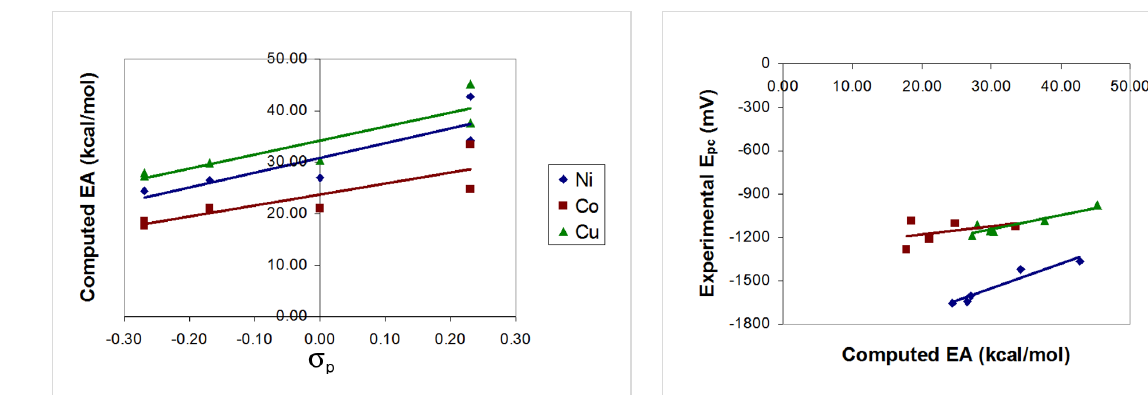
Figure 3: Correlation between E pc and EA for the Ni, Co, and Cu training set metal-salens (R 2 = 0.93, 0.17 (0.63 excluding salen 10 ), and 0.86 for Ni, Co, and Cu,